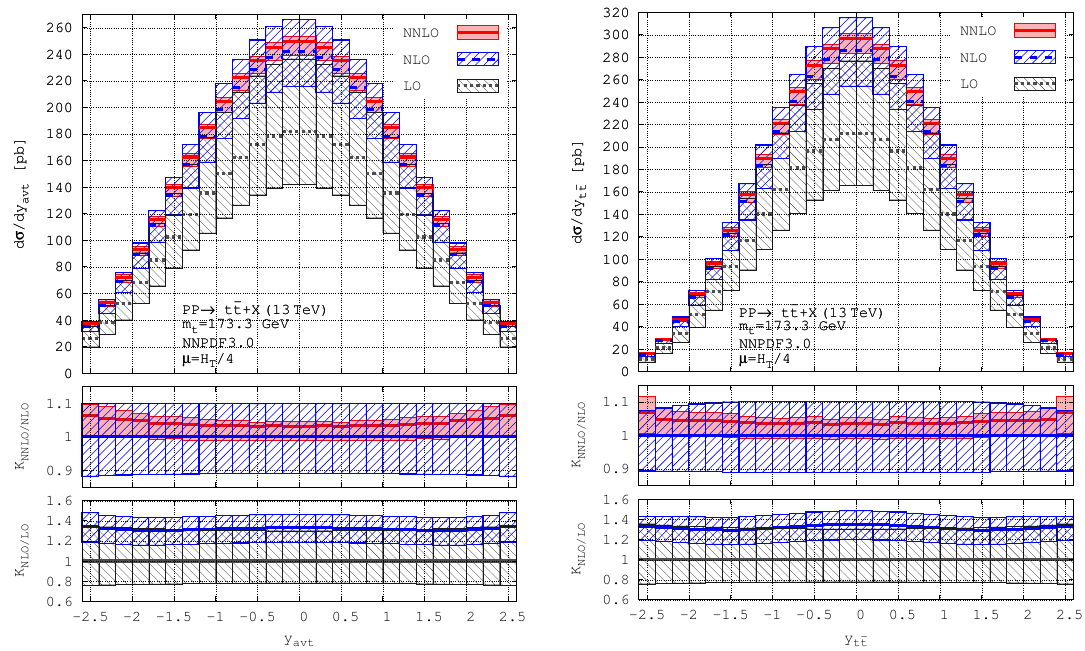
Figure 15 . The y (left) and y (right) distributions for LHC 13 TeV. Error bands are from scale t= (cid:22) t t (cid:22) t variation only.